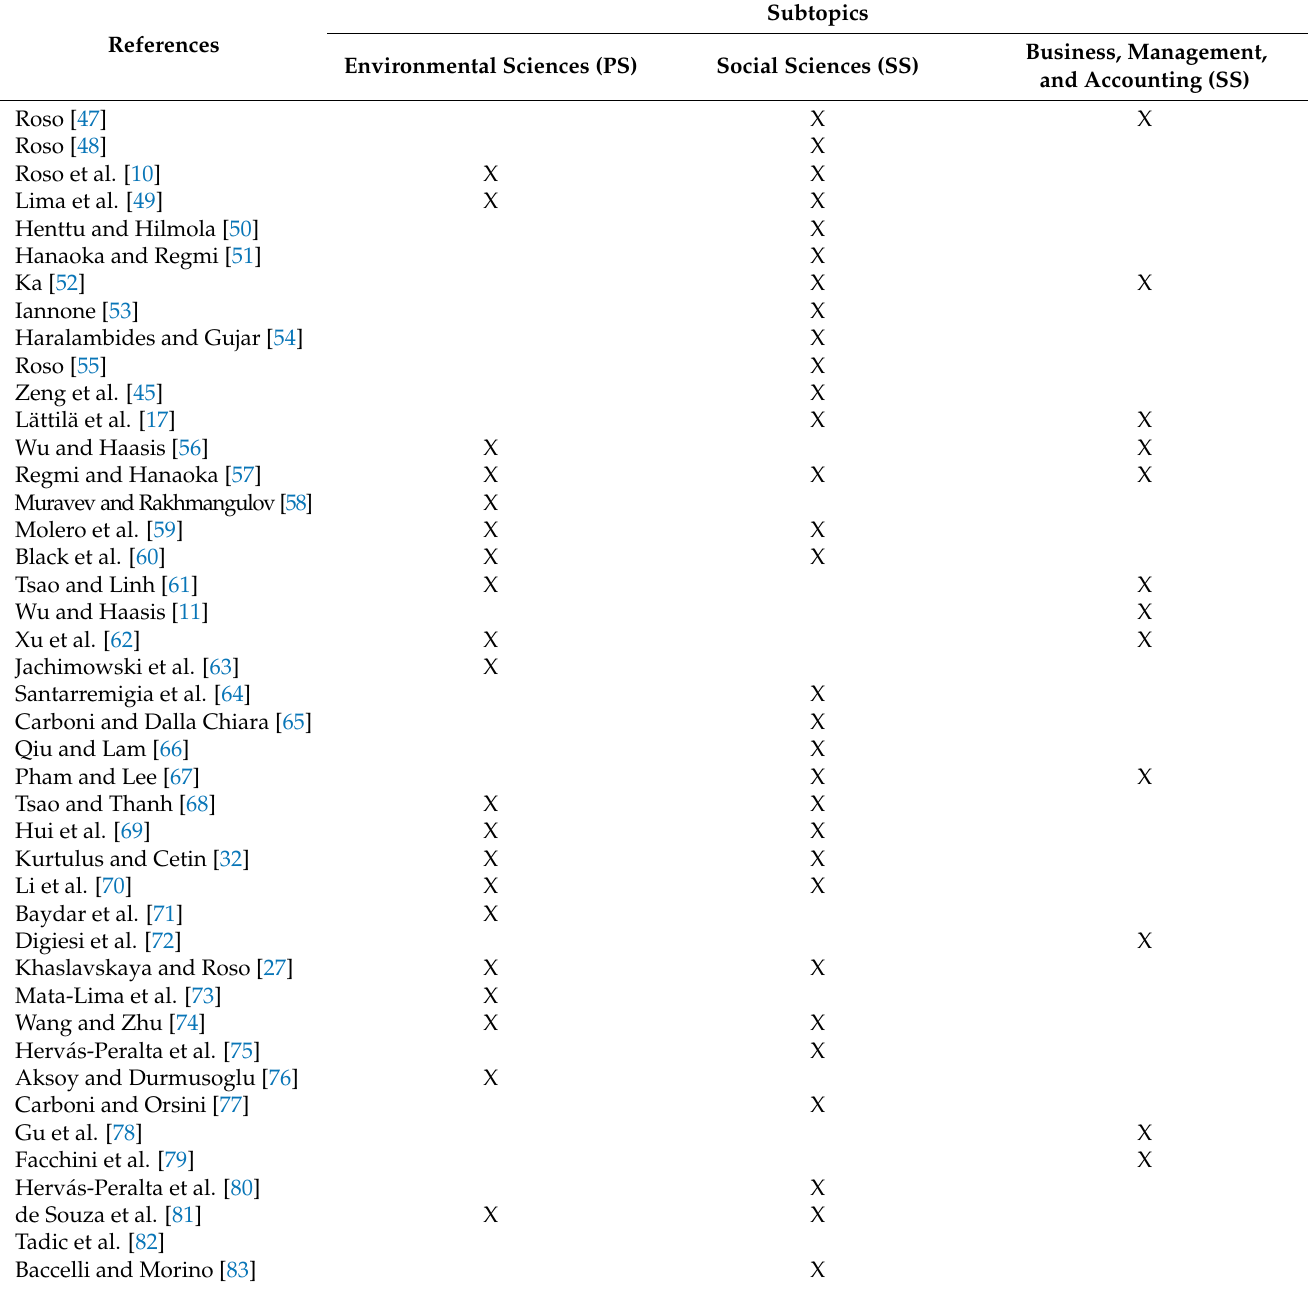
Table 2. Investigated subject and subtopics. Notes: PS = physical sciences; SS = social sciences; Source: personal elaboration by the